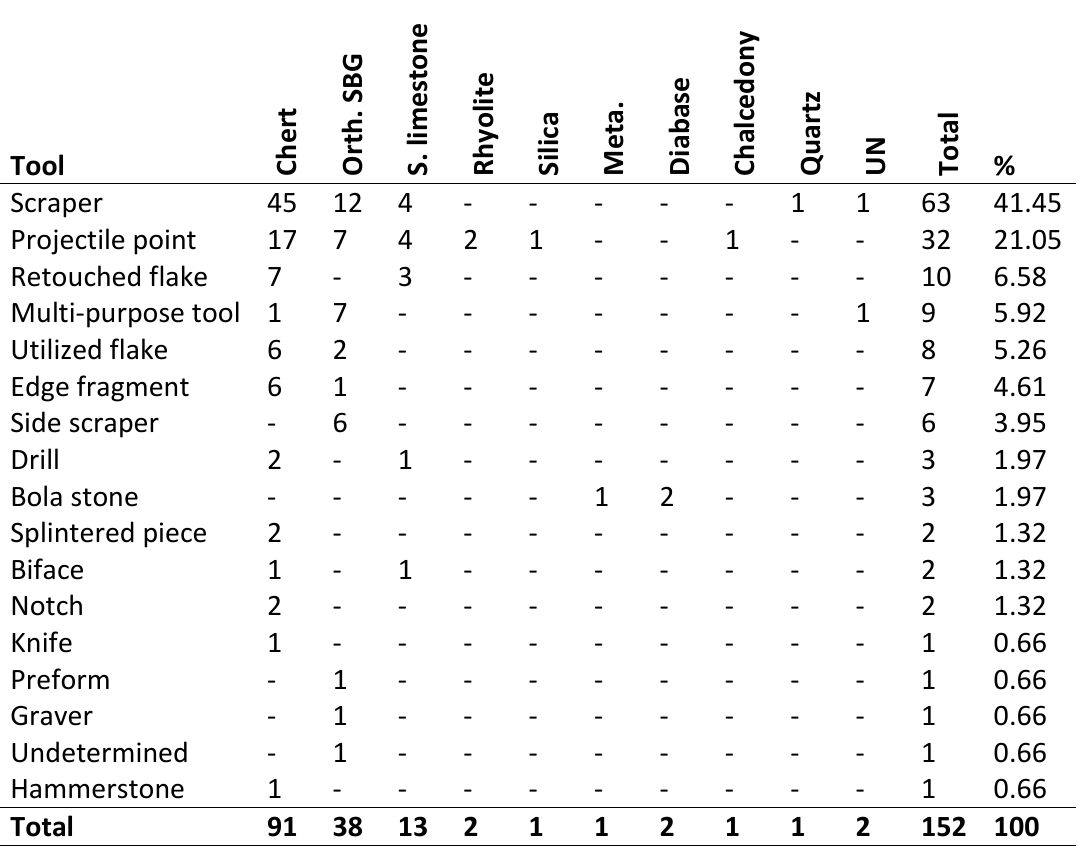
Table 3. Types of tools and raw materials of Hangar. Abbreviations: orth = orthoquartzite; S = silicified; meta = metaquartzite; UN = undetermined.